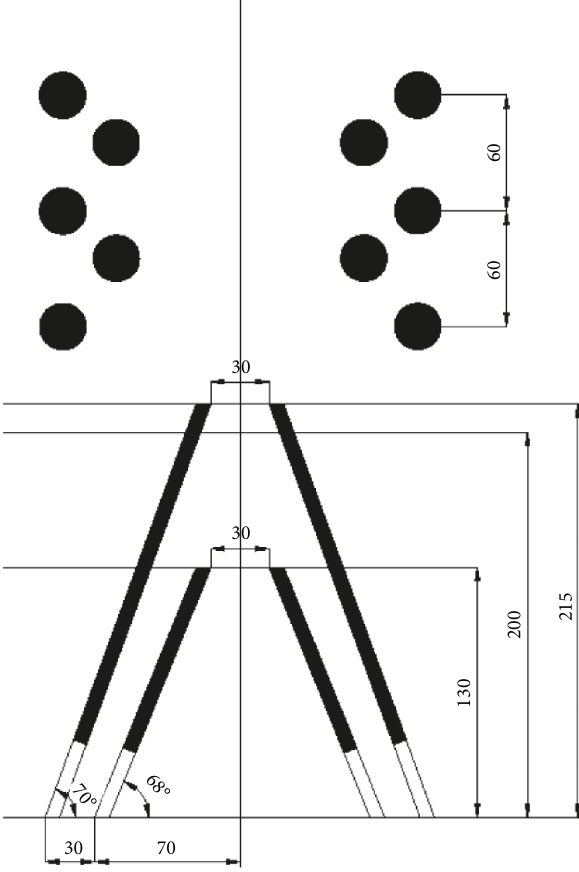
Figure 1: The specific cross-sectional arrangement of the holes (cm).